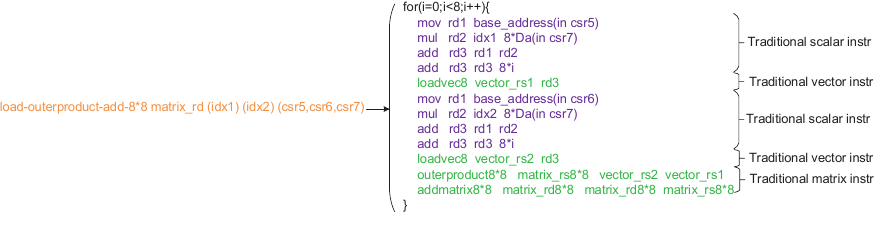
Figure 20. The matrix instruction equivalent.